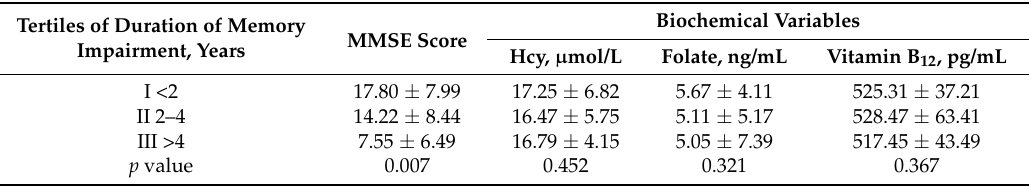
Table 2. Clinical and biochemical variables in patients with AD by duration of memory impairment at presentation.